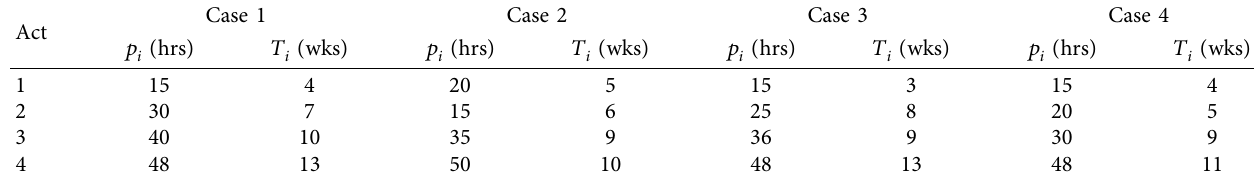
Table 9: Executions times and periodicities of each PM activity.